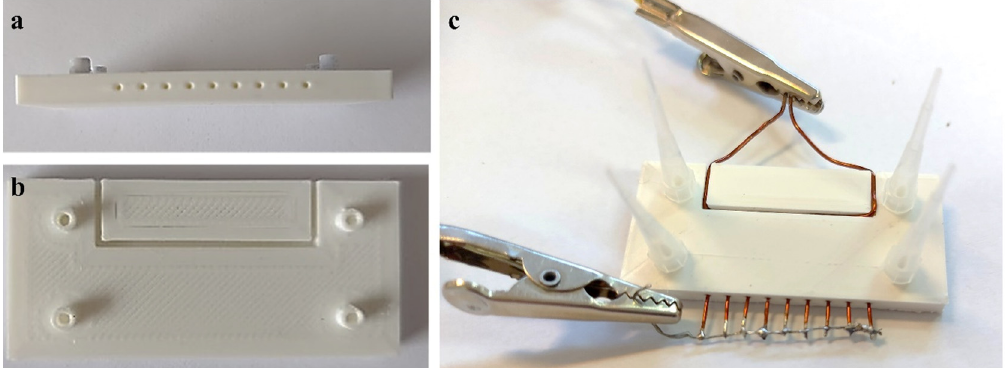
Figure 2. Printed microfluidic bioreactor: ( a ) side view; ( b ) top view; ( c ) microfluidic bioreactor with integrated electrodes.